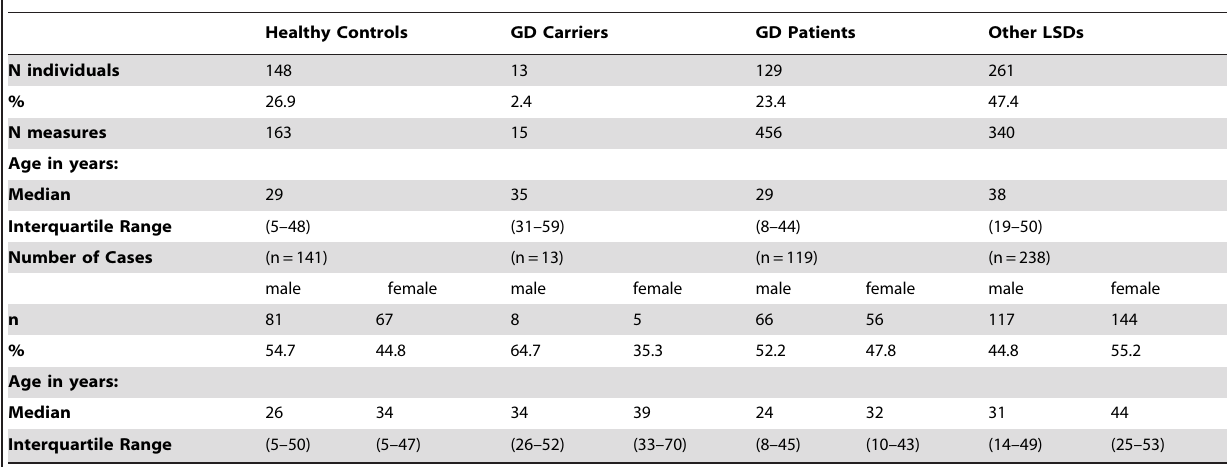
Table 1. Comparison of the four cohorts.